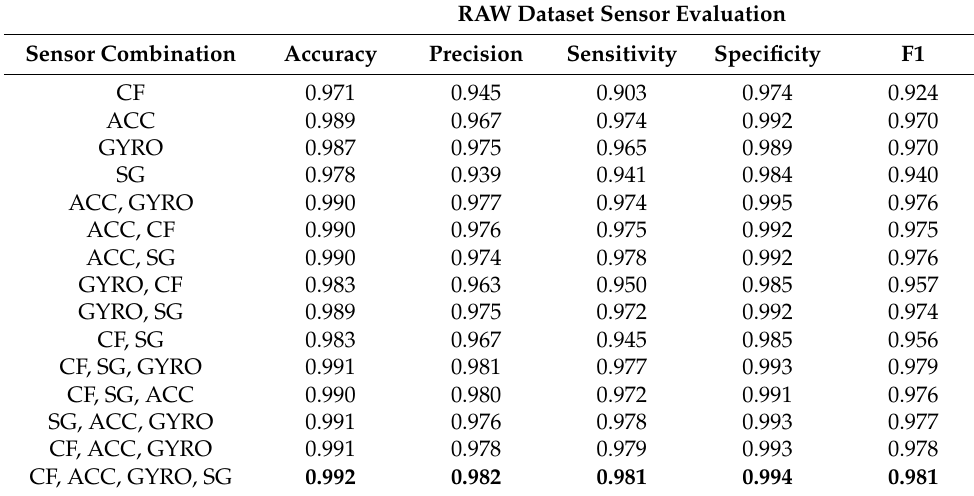
Table 7. Sensor importance evaluation.